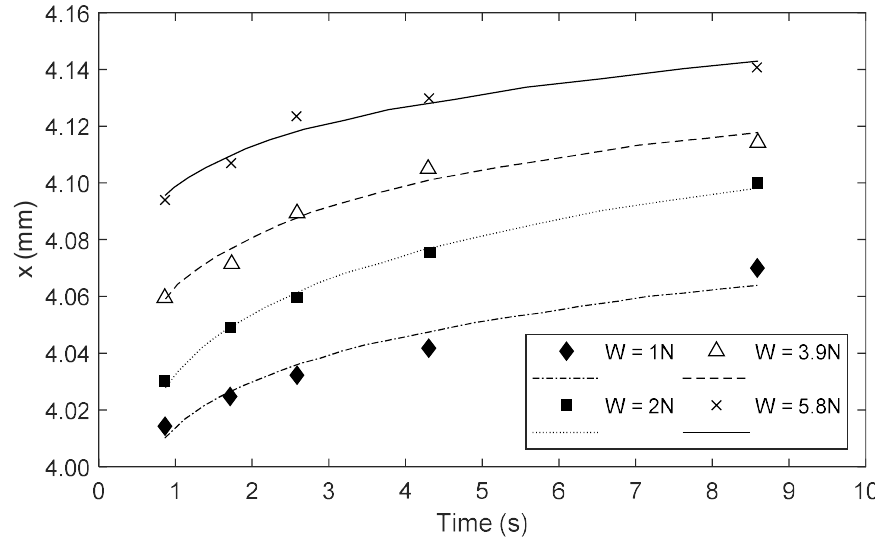
Figure 6. Growth of contact area with viscoelastic relaxation.